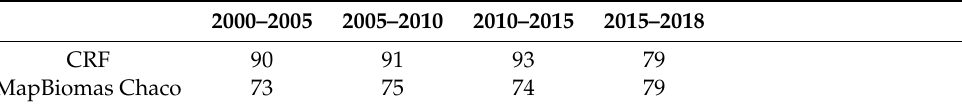
Figure A2. Data density across the study region. Data density was calculated by binning latitudes (7 bins) and taking the average clear-sky count from 1 July to 1 July of each 12-month period across each latitude bin. Table A1. Overall accuracy (%) of two land cover products for four different time periods. These accuracy numbers were generated using the same set of validation samples used in the unbiased assessment. To compare the two maps at a comparable legend, we recoded MapBiomas Chaco maps to match our land cover legend as close as possible. The MapBiomas Chaco product contains twenty land cover categories, including multiple tree cover (all woodland classes were recoded to “trees” except “flooded natural woodlands”) and grassland (all grassland categories were recoded to “grassland” except “flooded grassland”)